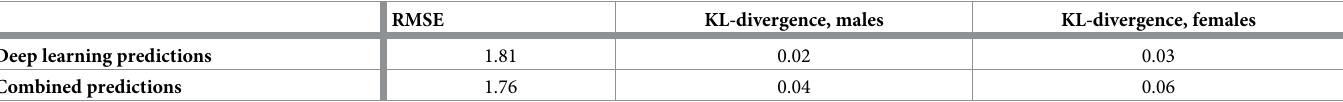
Table 4. Results after including length-based predictions as a second age estimate. Summary results for image-based estimates (deep learning predictions), and a combi- nation of image-based and length-based estimates (combined predictions).